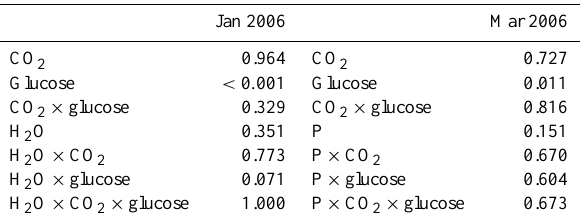
Figure 4. Effect of elevated-CO 2 concentration on available P in soils over time using two methods, extractable soil P (open tri- angles) and ion-exchange resins (filled circles). Values are the ef- fect size of elevated CO 2 , expressed as a percentage: (E − A)/A × 100%. Bars denote 5 and 95% confidence limits. (Data from 1997 to 2001 were calculated from raw data reported in Johnson et al., 2001,